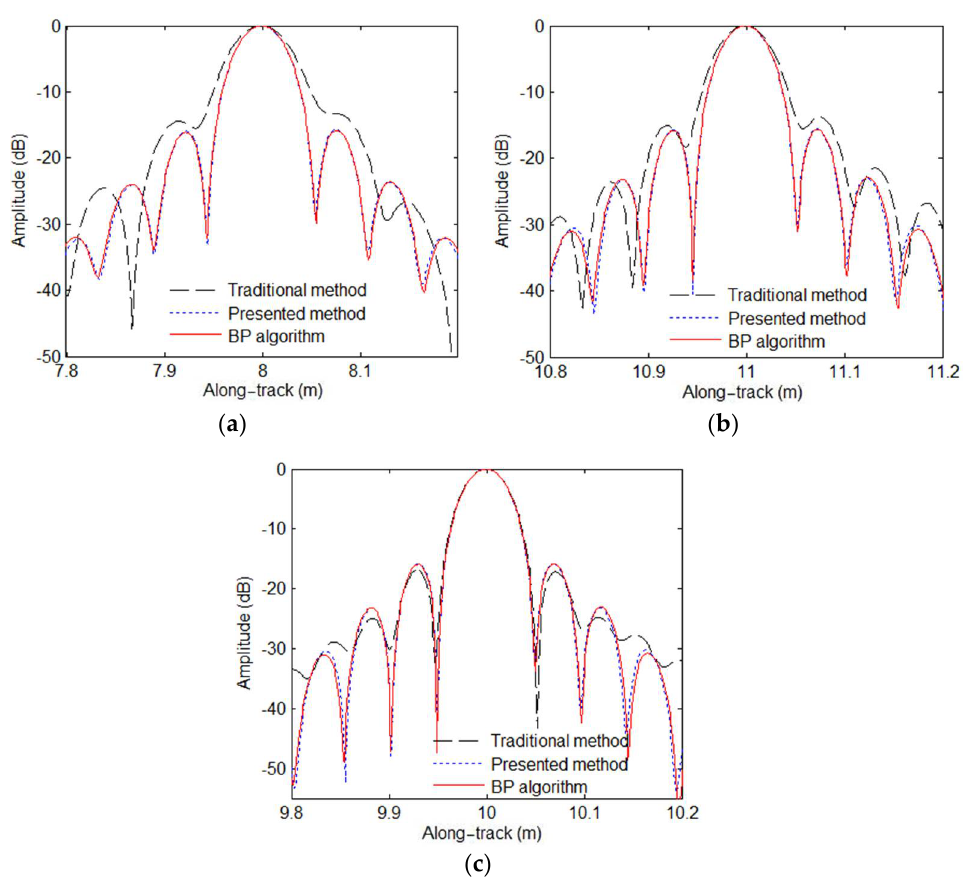
Figure 17. Along-track slices with the case of a wide-bandwidth signal. ( a ) T1; ( b ) T2; ( c ) T3. Table 6. Comparison of imaging quality with the wide-bandwidth case.